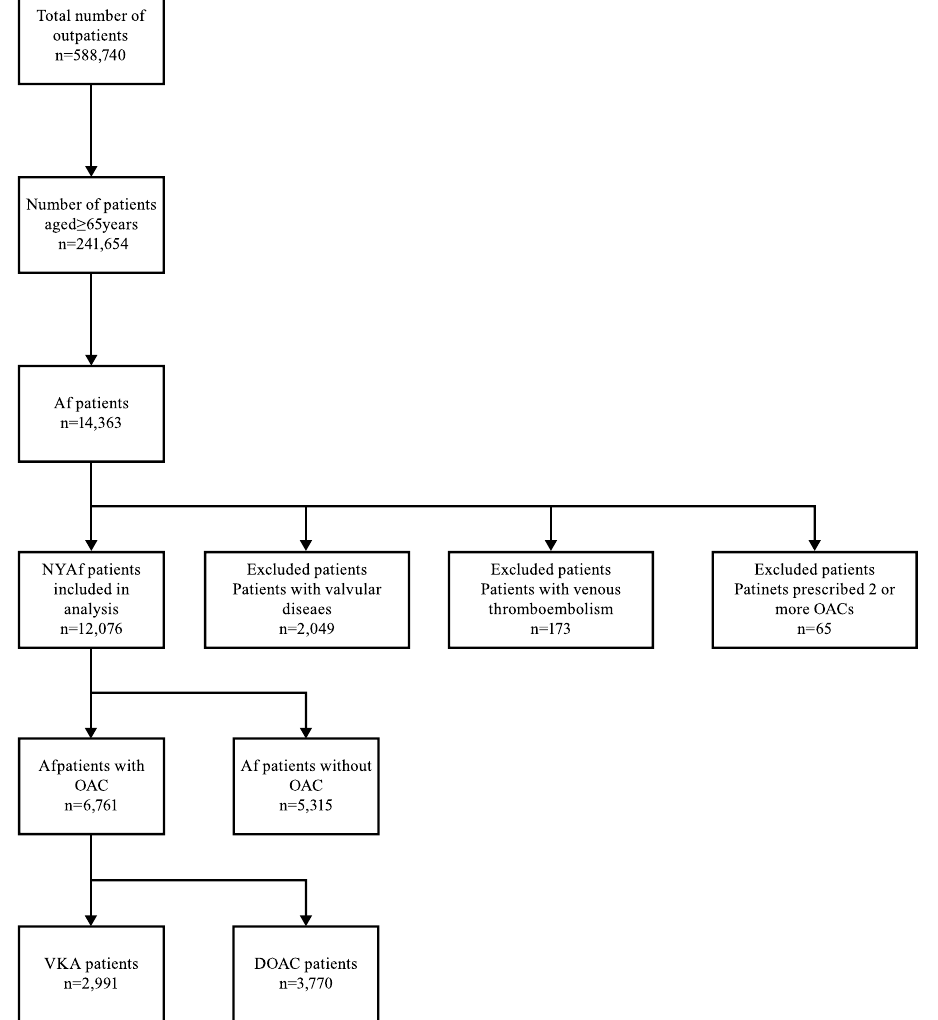
Figure 1. Flowchart of subject extraction (2015). Figure shows extraction proses of patients aged ≥ 65 years from the 2015 outpatient claims data. Af Atrial fibrillation, NVAf None valvular Atrial fibrillation, OAC oral anticoagulant, VKA vitamin K antagonist, DOAC direct oral